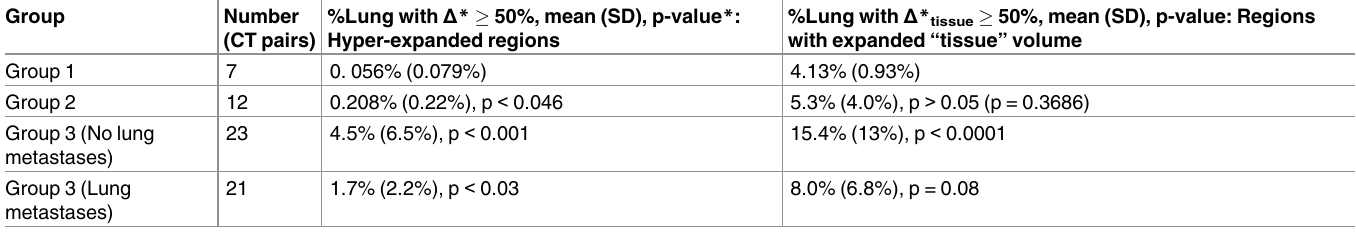
Table 3. Percent lung volume of hyper-expanded regions and regions of expanded tissue volume. Group